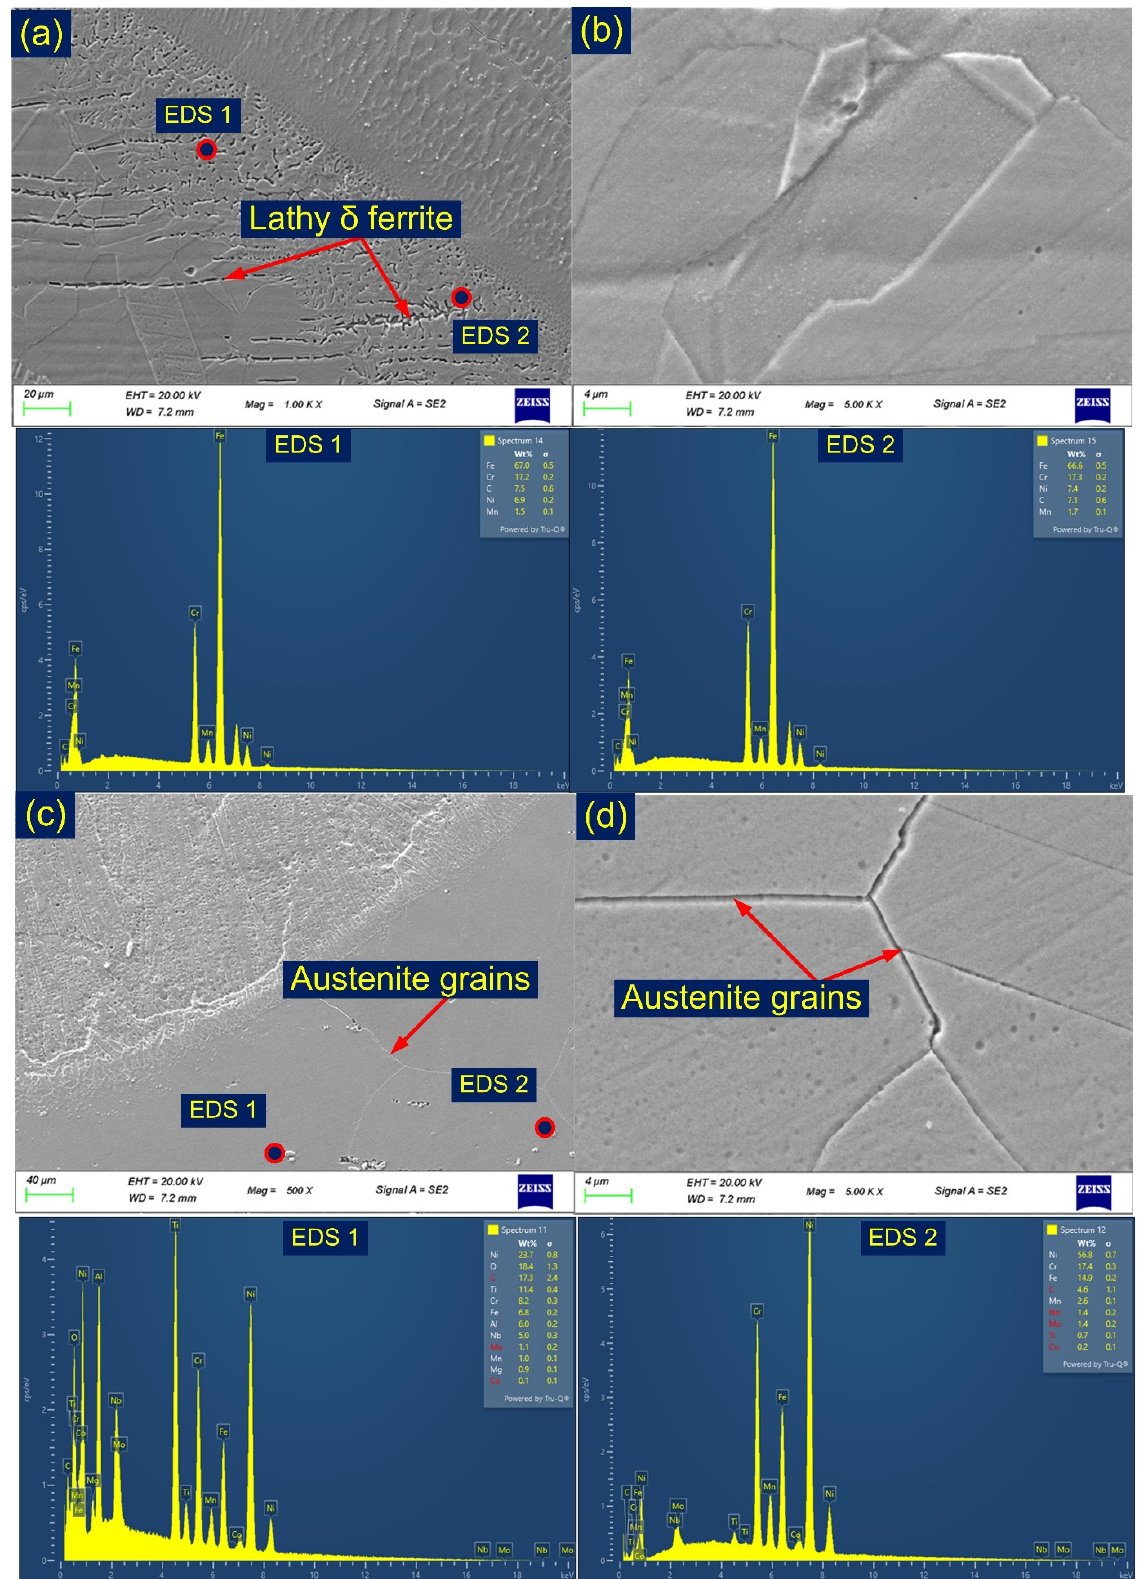
Figure 7. ( a , b ) Interface and HAZ of 304L SS along with EDS results, ( c , d ) interface and HAZ of IN718 alloy along with EDS results.